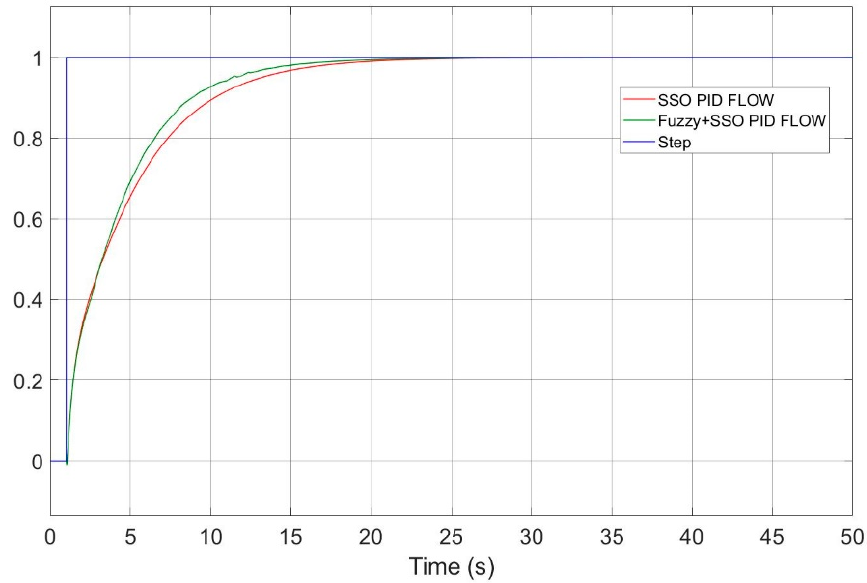
Figure 20. Flow versus time plot for PID tuned with SSO and SSO fuzzy. Appl. Sci. 2020 , 10 , x FOR PEER REVIEW